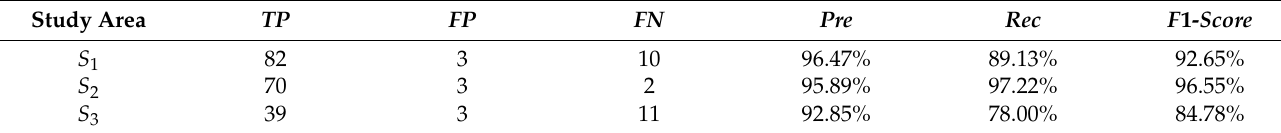
Table 4. Accuracy evaluation of the experimental results.